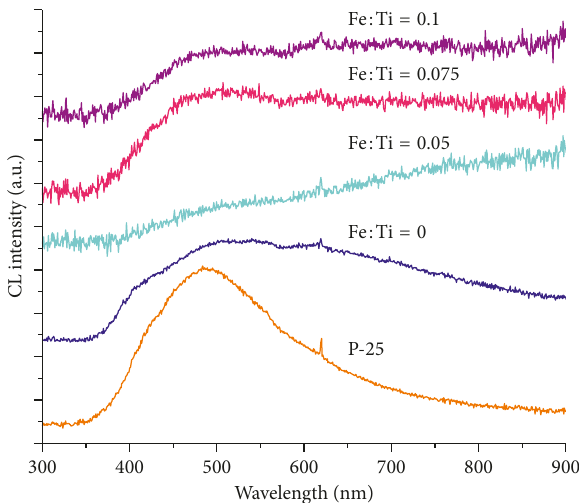
Figure 5: CL measurements of TiO Fe 3+ :Ti molar ratios.